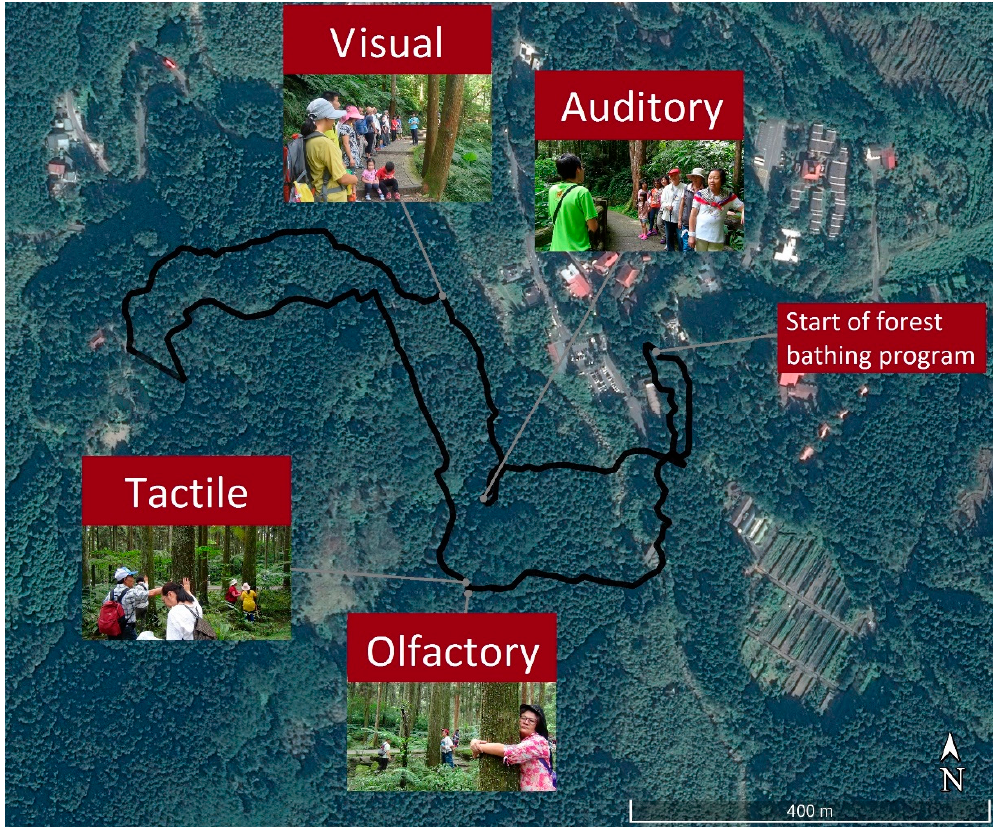
Figure 1. Walking course and various activities of the forest bathing program superimposed on a location map.